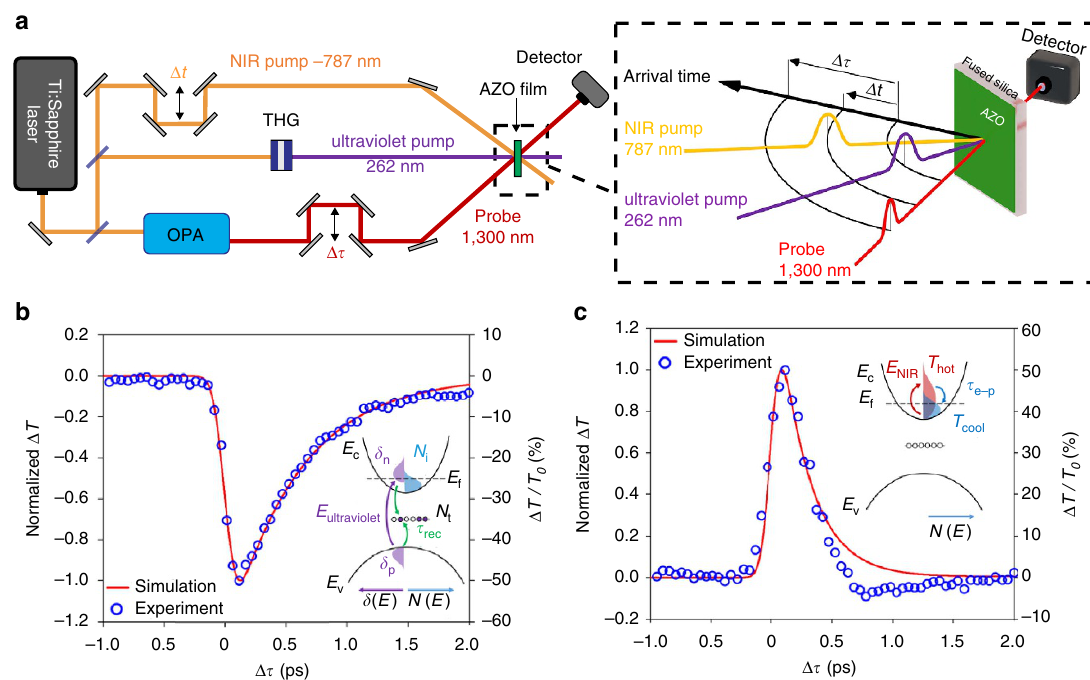
Figure 1 | Two-colour pump–probe experiment. ( a ) Schematic of the two-colour pump–probe experimental set-up where the two pump wavelengths, 787nm (NIR) and 262nm (ultraviolet), are illustrated along with the probe wavelength of 1,300nm. The delay between the two pump pulses is denoted D t while the delay between the probe and ultraviolet signal is denoted D t . For intraband excitation using only the NIR pump, D t is defined as the delay between the probe and NIR pump pulse arrival time. The black arcs indicate the arrival time of the pulses. ( b ) Change in transmission at 1,300nm versus the pump–probe delay D t under 262nm excitation fitted with simulation. The inset illustrates the process diagram for interband excitation: ultraviolet light ( E ultraviolet ) generates electron–hole pairs ( d n , d p ) above the Fermi level ( E f ) in addition to the intrinsic concentration ( N i ), which recombine through mid-gap trap states ( N t , t rec ). ( c ) Change in transmission at 1,300nm versus the pump–probe delay D t under 787nm excitation fitted with simulation. The inset illustrates the process diagram for intraband excitation: NIR light ( E NIR ) raises the temperature of conduction band electrons ( T cool - T hot ), which relax through scattering processes ( t e (cid:2) p ), heating the lattice. The change in transmission from the experiment was obtained through D T ¼ ( T (cid:2) T 0 )/ T 0 , where T 0 is the transmission of the probe far from the pump pulse. For comparison with the theoretical results, the amplitude of the induced transmission change was normalized using D T normalized ¼ D T /| D T max |, where | D T max | is the magnitude of the peak change in transmission. The same procedure was completed for the simulation